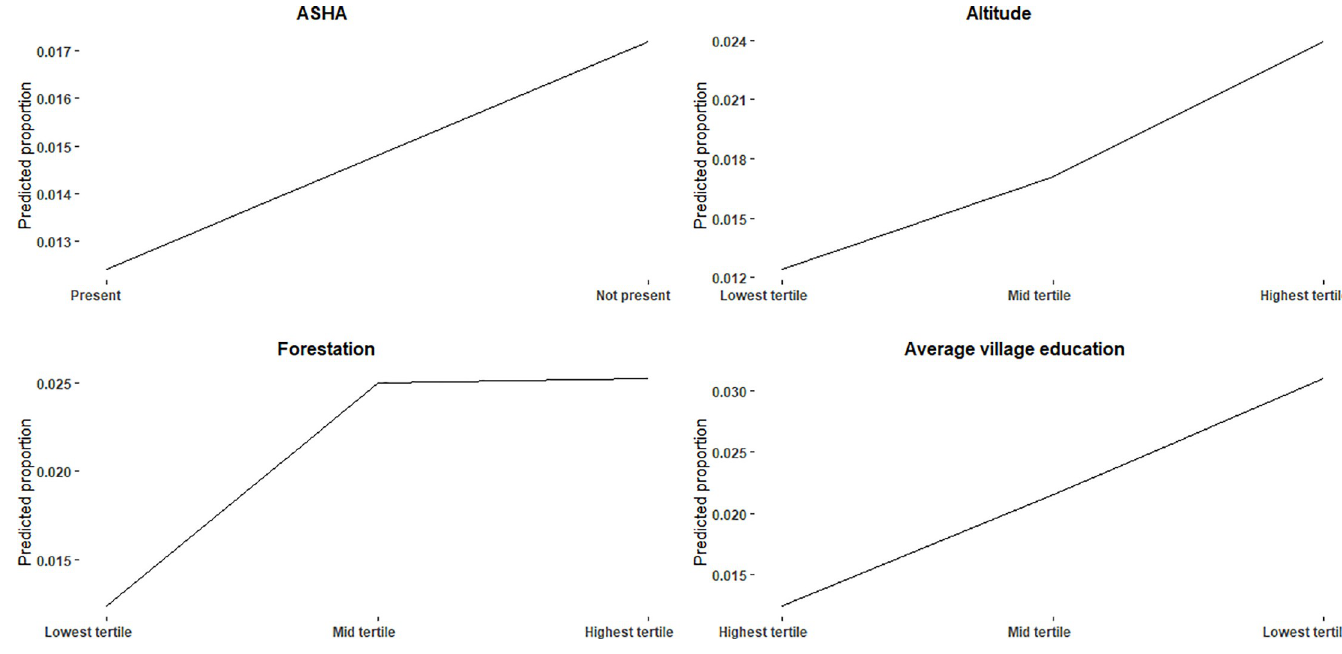
Fig 1. Predicted proportion for Malaria.